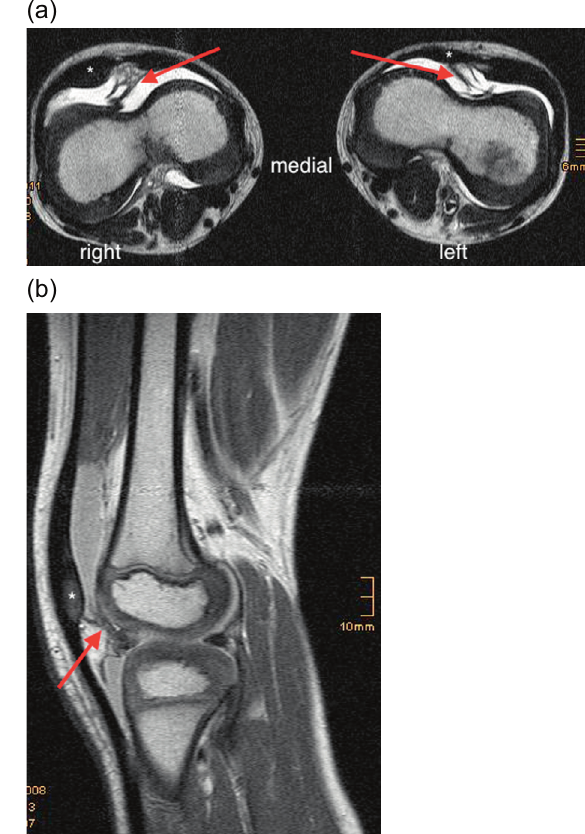
Figure 2. (a) Preoperative axial MRI of both knees in a six-year- old boy shows a deep femoral trochlea with a septum (red arrow), dividing the knee joint in a medial and lateral half and positioning the patella on the lateral side of the septum; patella ossification center (*). (b) Sagittal MRI through the lateral femoral condyle articulating with the patella ossification center (*); septum (red arrow).